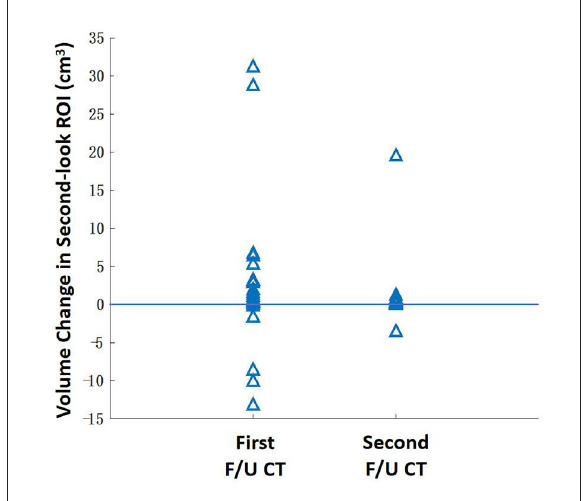
FIGURE7 The change of the lesion ROI volume between the original ROI drawing and the second-look ROI redrawing using the mapped baseline ROI as the reference. The ROI of some patients with extensive diseases may show a higher volumetric change. Overall, the second-look ROI drawing has a significantly higher volume ( P < 0.05) for the first F/U and second F/U